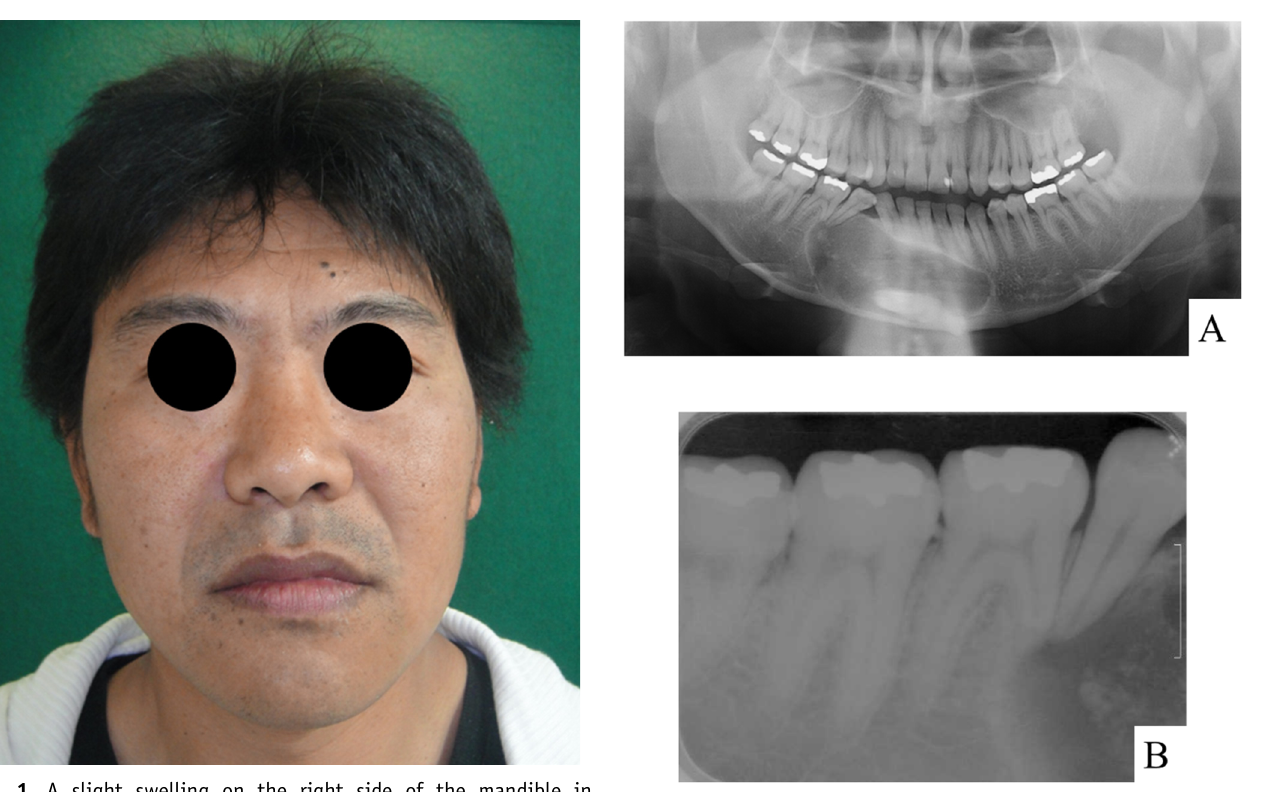
fi ned, unilocular radiolucent lesion in the mandible. The large lesion was associated with the impacted and displaced right fi rst premolar (A). Root resorption was also evident in relation to the right second premolar and the right fi rst molar (A and